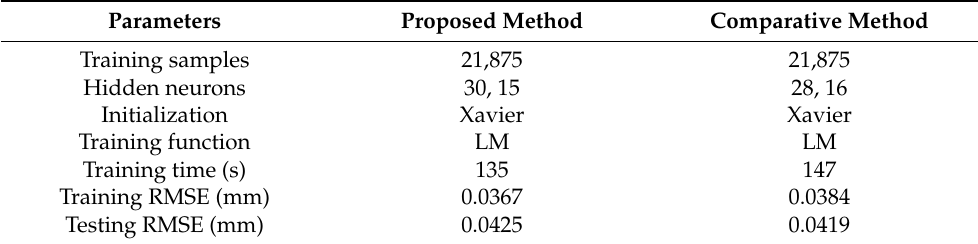
Table 4. Training parameters of two neural networks.